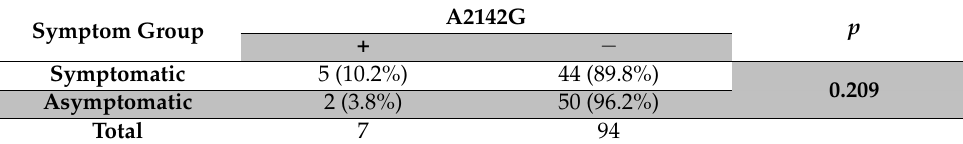
Table 5. The distribution of A2142G mutation by symptom group.